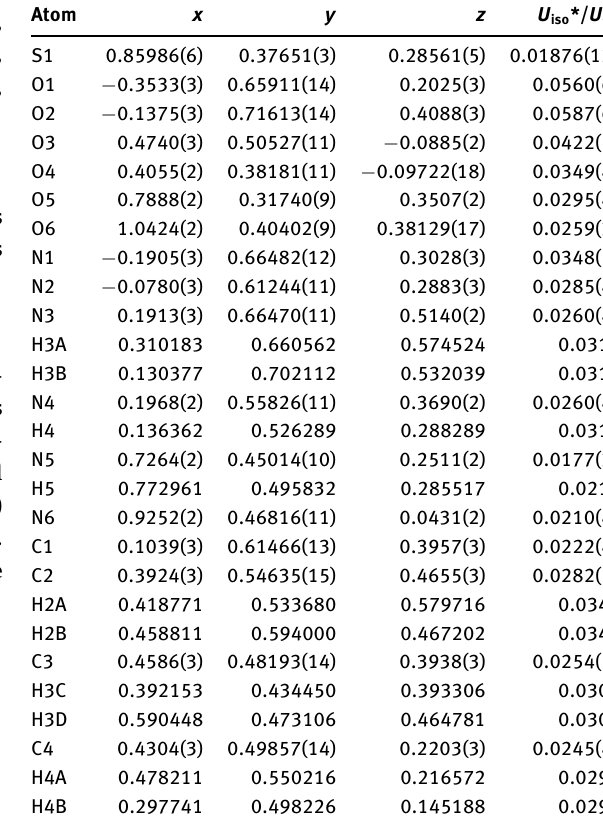
Table 2: Fractional atomic coordinates and isotropic or equivalent isotropic displacement parameters (Å 2